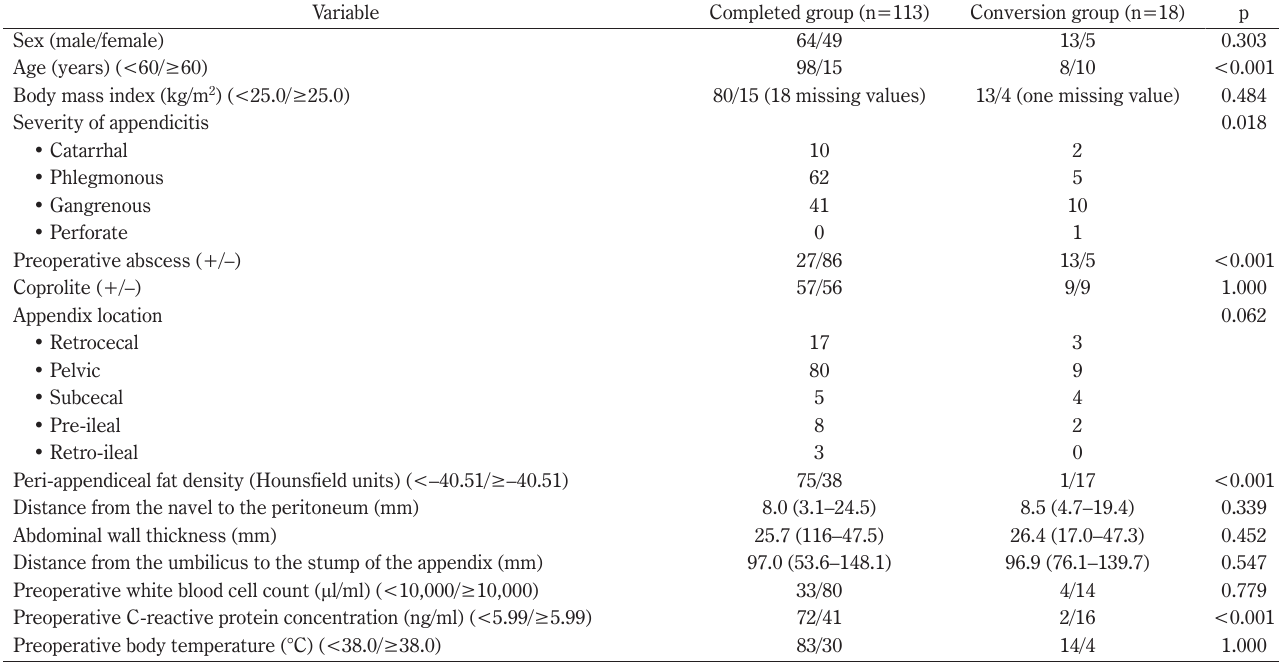
Table 2 Univariate analysis of the demographic and preoperative variables to determine the risk factors for conversion